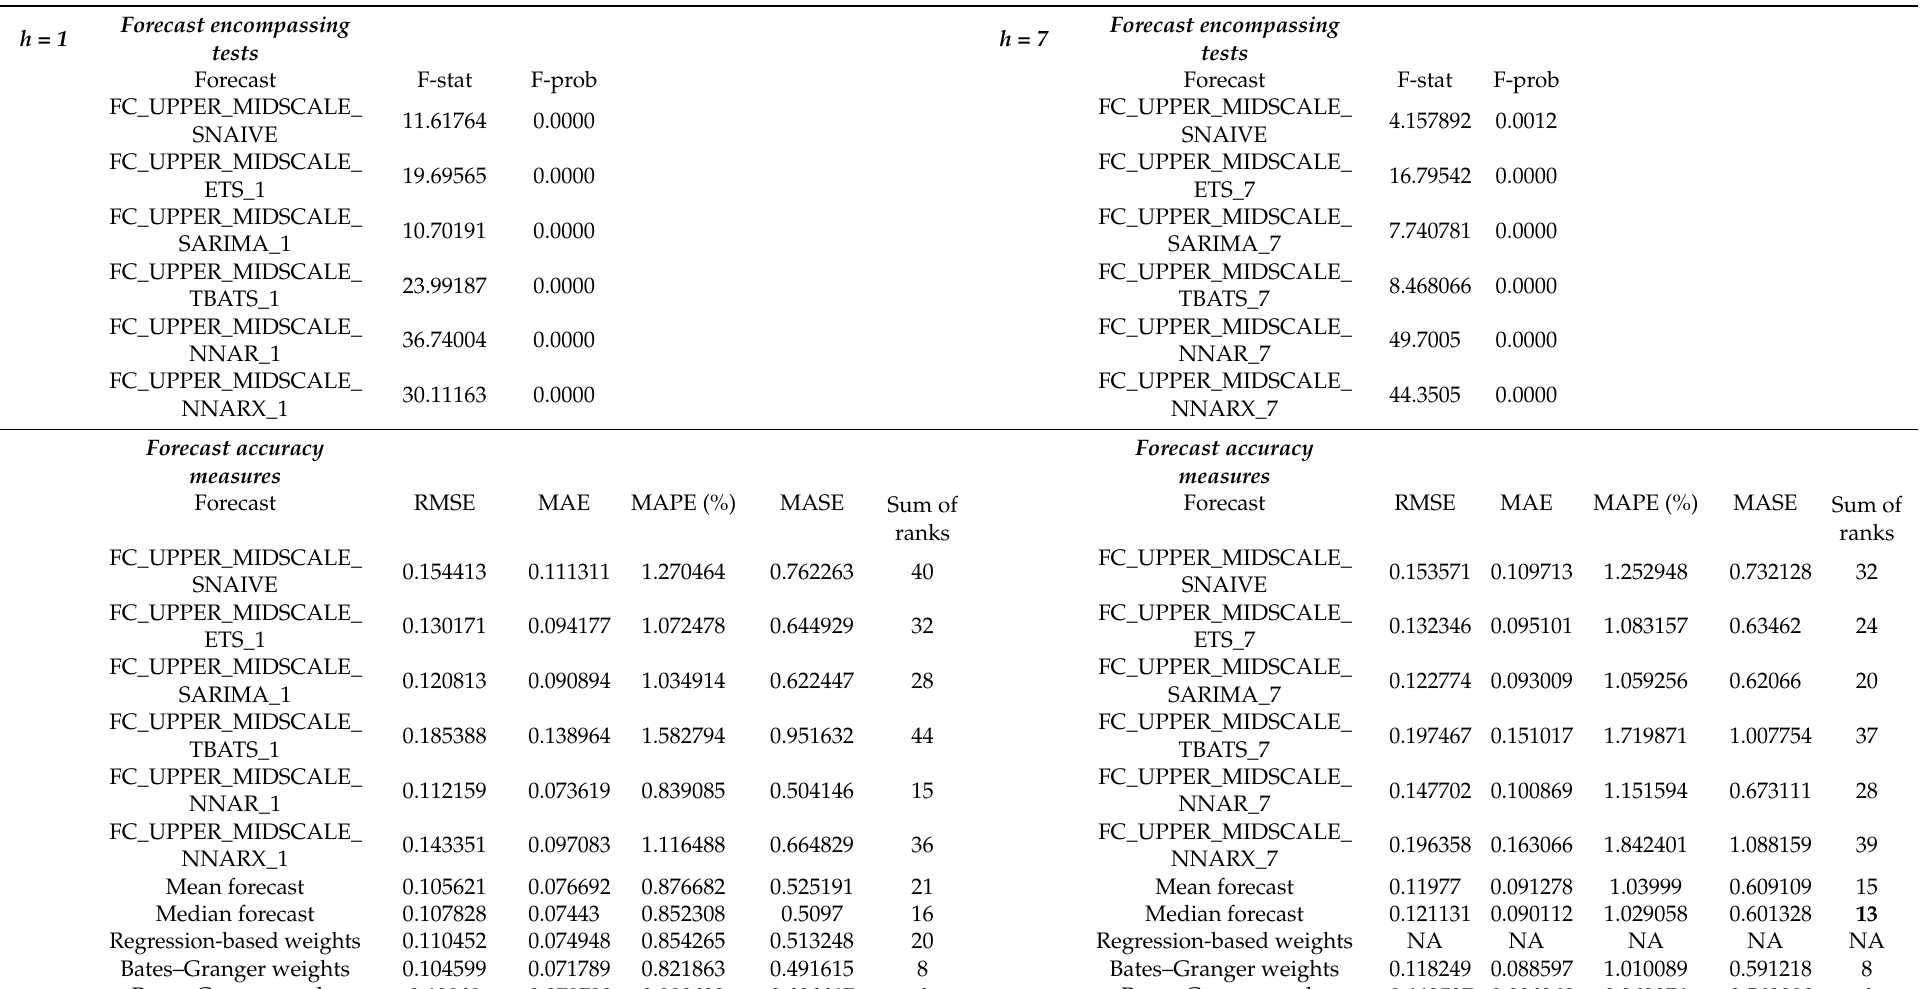
Table A4. Forecast evaluation results for the hotel class ‘upper midscale’. Source: STR SHARE Center, own calculations using R and EViews. h =